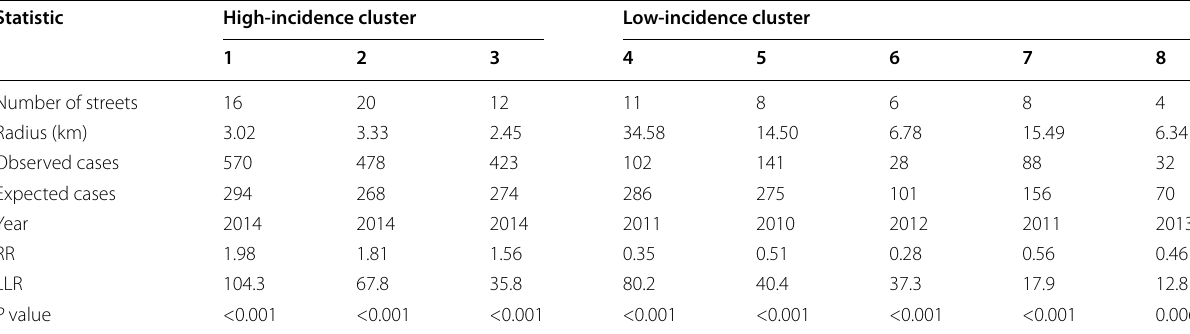
Table 2 Colorectal cancer incidence statistics for the space–time analyses, Guangzhou, China during 2010–2014